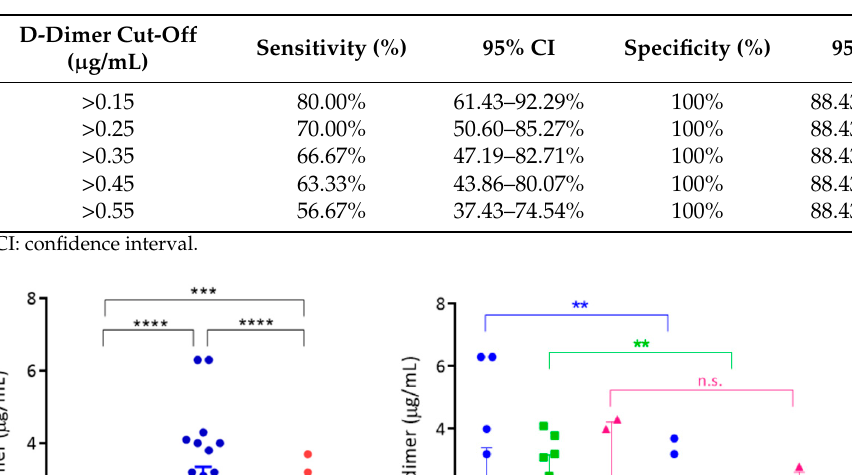
Table 2. Sensitivity and specificity of D-dimer.